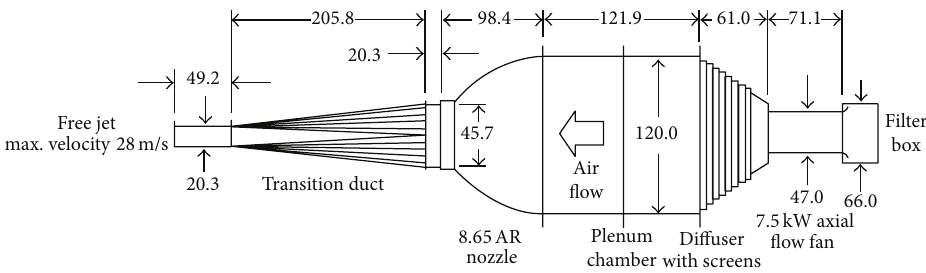
Figure 4: Calibration wind tunnel, dimensions in centimeters (not to